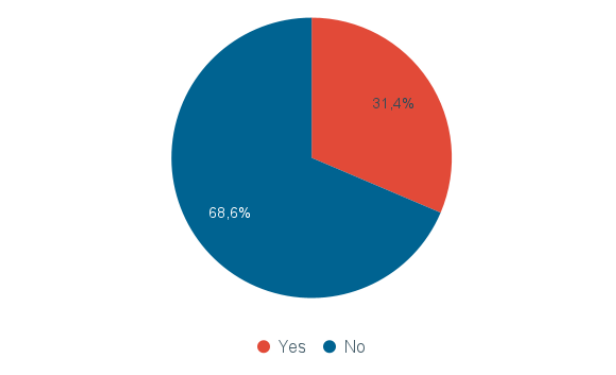
Figure 19. Did you know Ada Lovelace before the game? - Test